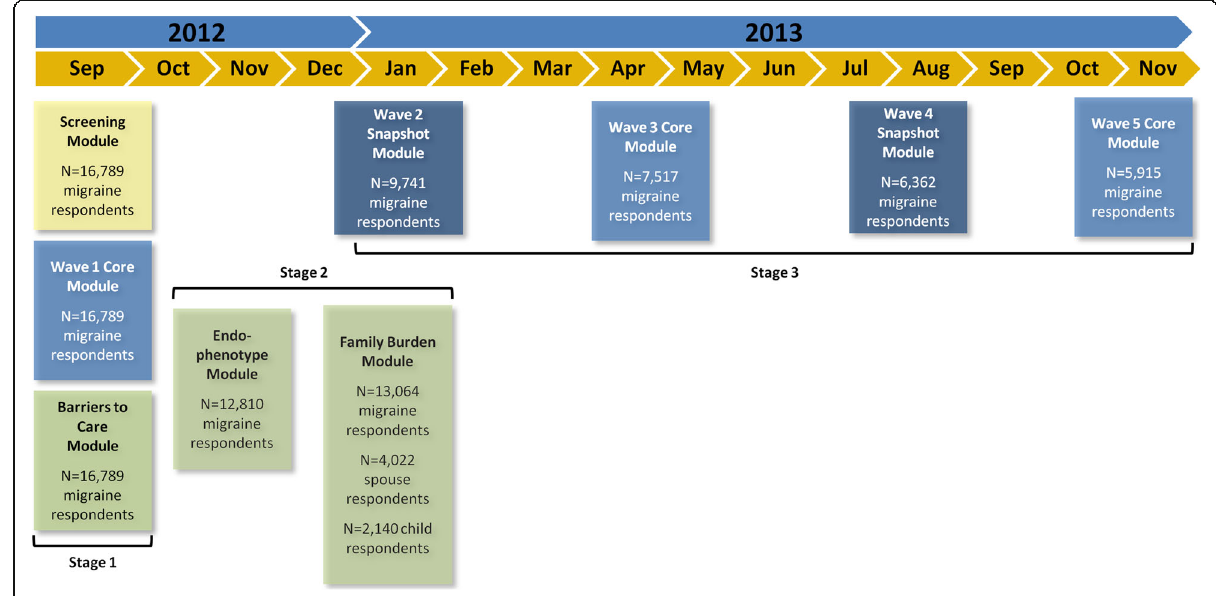
Fig. 1 CaMEO study design, reprinted from Manack Adams A, et al. Cephalalgia 2015;35:563 – 578.